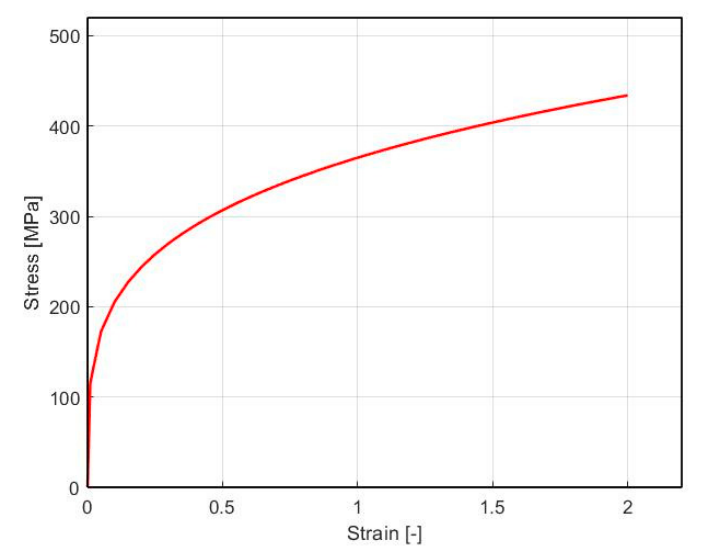
Figure 2. The flow stress data of aluminum alloy. The tools of the ECAR equipment (the die and working rolls) were considered a rigid body which implies no plastic deformation was induced during deformation. The groove and guide rolls were spinning at a speed of 0.02 rad/s. Boundary conditions of the friction on the interface between the ECAR die and billet was modeled using the constant shear model: